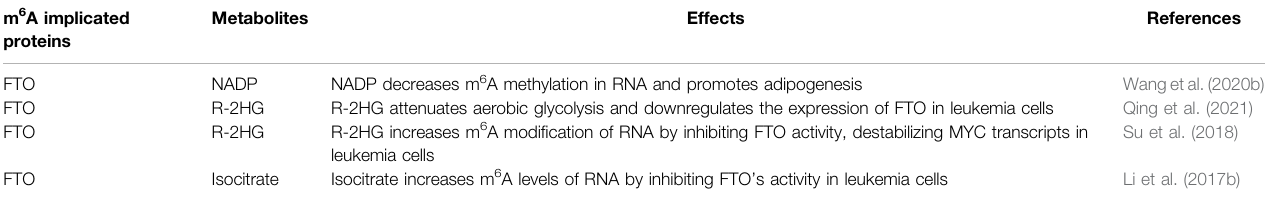
TABLE 2 | Control of m 6 A by metabolites in